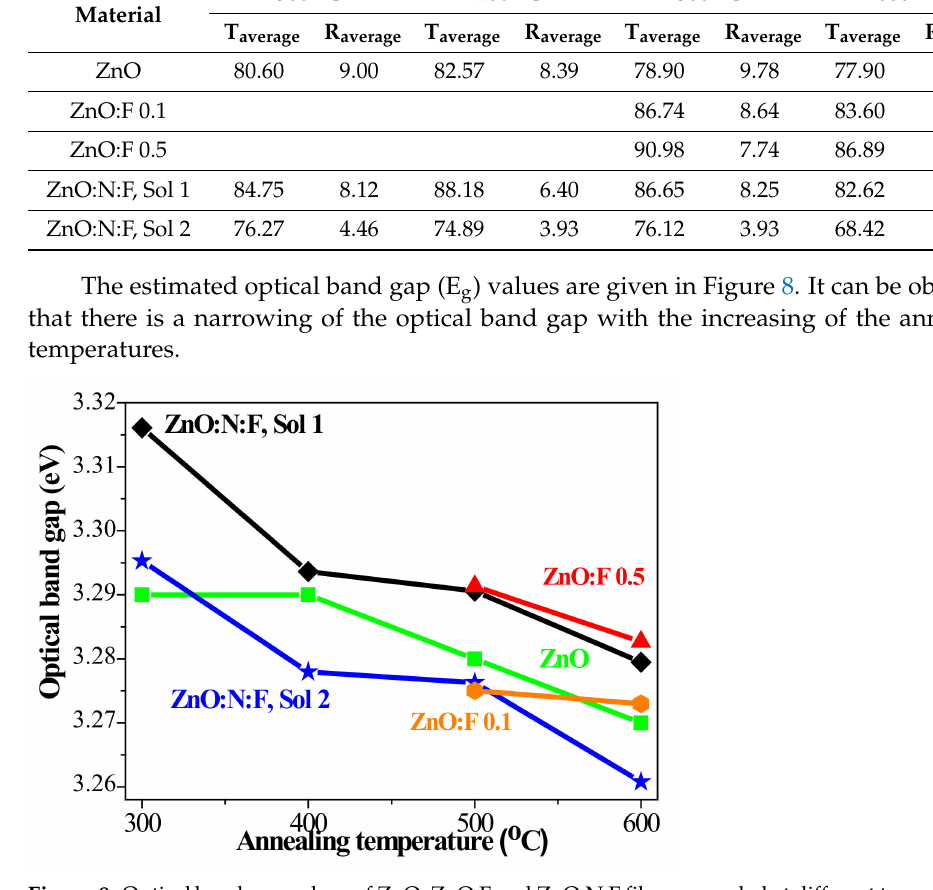
Figure 8. Optical band gap values of ZnO, ZnO:F and ZnO:N:F films, annealed at different temperatures. It is known that optical band gap narrowing can be caused by defects and greater crystallite sizes [55]. The optical band gap (E g ) of ZnO:N:F films (Sol 1) is wider compared